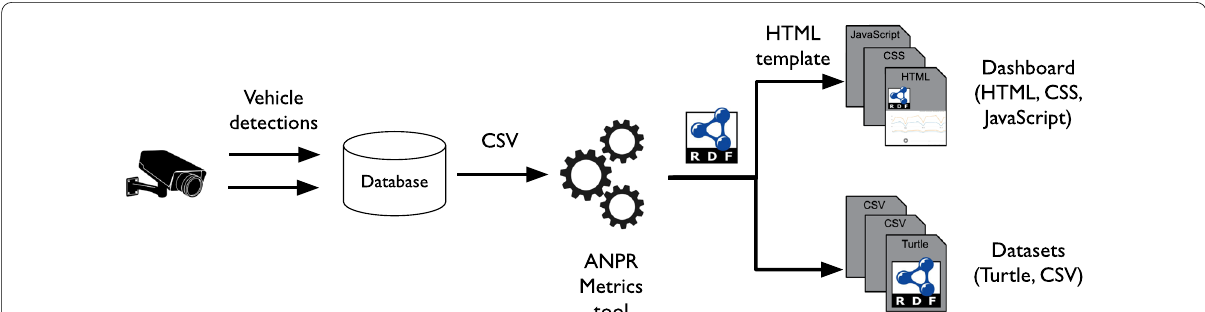
Fig. 3 ANPR Metrics tool generates a dashboard and datasets from ANPR dataset